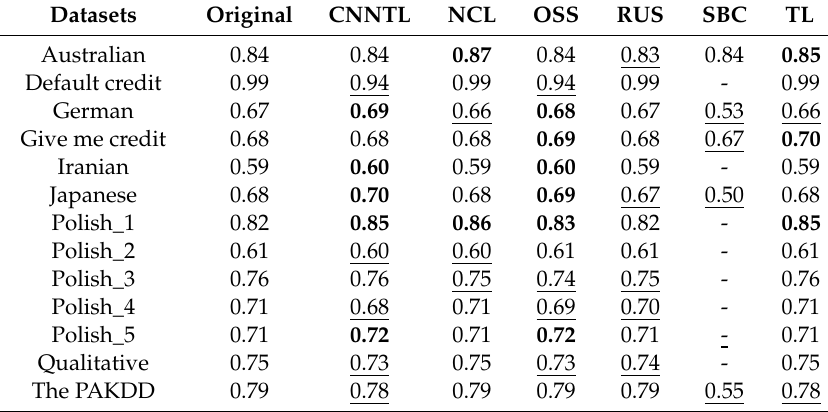
Table 13. AUC for the Extended Gamma classifier after undersampling